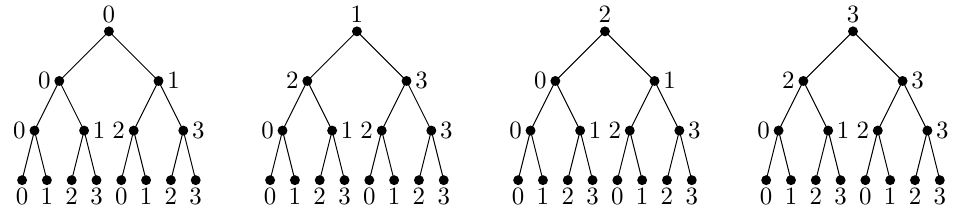
Figure 6: A collection of trees with collision-free depth of